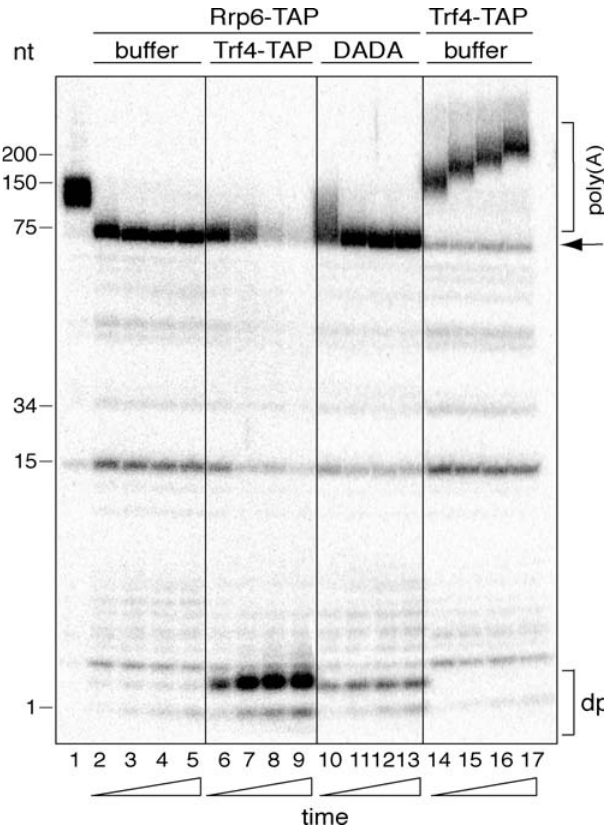
Figure 7. Efficient Degradation of tRNA iMet May Involve Multiple Rounds of Deadenylation and Readenylation Uncoupled exosome assay on pre-adenylated tRNA. 5 9 -end-labeled and in vitro polyadenylated unmodified tRNA iMet was incubated with 50 ng of affinity-purified Rrp6-TAP eluate alone or in combination with 50 ng of wild-type (Trf4-TAP) or mutant (DADA) complex or 50 ng of Trf4-TAP alone. Reactions were stopped after 30 (lanes 2, 6, 10, and 14), 60 (lanes 3, 7, 11, and 15), 90 (lanes 4, 8, 12, and 16), or 120 min (lanes 5, 9, 13, and 17) and separated on a 15% gel. The arrow indicates the position of the nonadenylated tRNA. Protein was omitted in lane 1. The migration positions of the polyadenylated tRNA (poly[A]) and the degradation products (dp) are indicated by brackets. DOI: